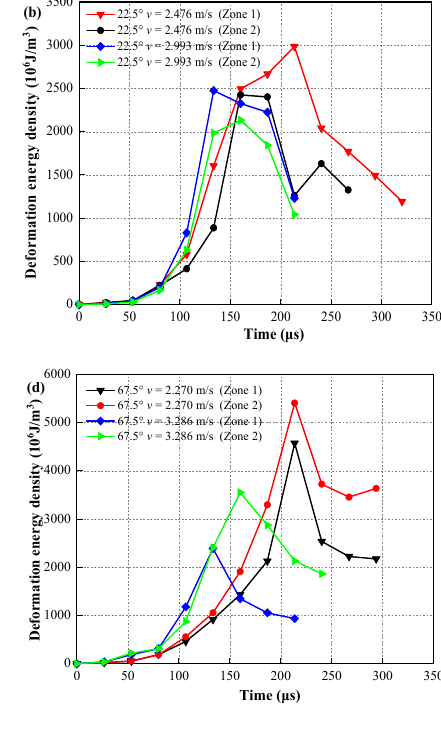
Figure 17. Deformation energy density and tensile displacement characteristics of coal specimens with bedding orientation of 0 ◦ . ( a ) Deformation energy density. ( b ) Relative tensile displacement.